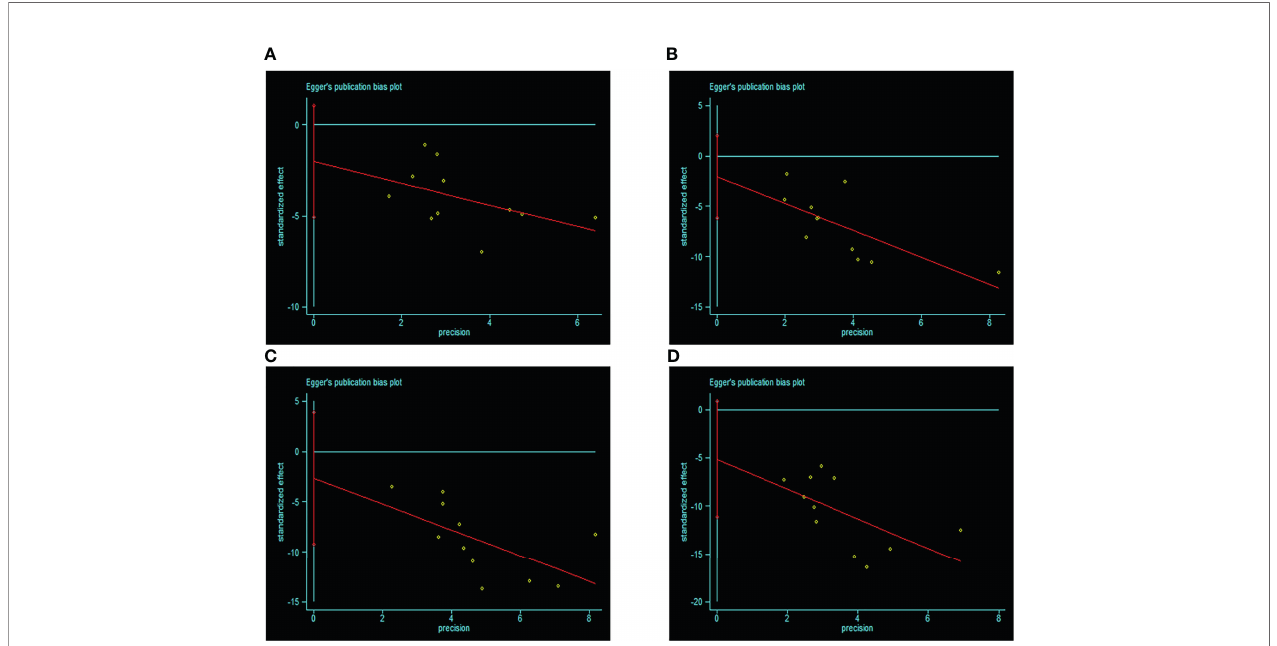
FIGURE 6 | Egger ’ s funnel plot of included studies for publication bias in WHO 1999 subgroup [ (A) IGT+IFG group VS I-IGT (IGT+NFG) group. (B) I-IFG groups VS NFG+NGT group. (C) I-IGT (IGT+NFG) VS NFG+NGT group. (D) IGT+IFG VS NFG+NGT group]. Egger ’ s test result showed that there was no publication bias (p > 0.05). 95% CI, 95% con fi dence interval; I-IGT, isolated impaired glucose tolerance; IGT+IFG, impaired fasting glucose combined with impaired glucose tolerance; I-IFG, isolated impaired fasting glucose; NFG+NGT, normal fasting glucose combined with normal glucose